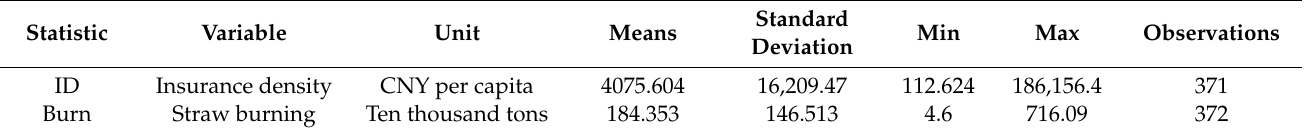
Table 10. Descriptive statistics of